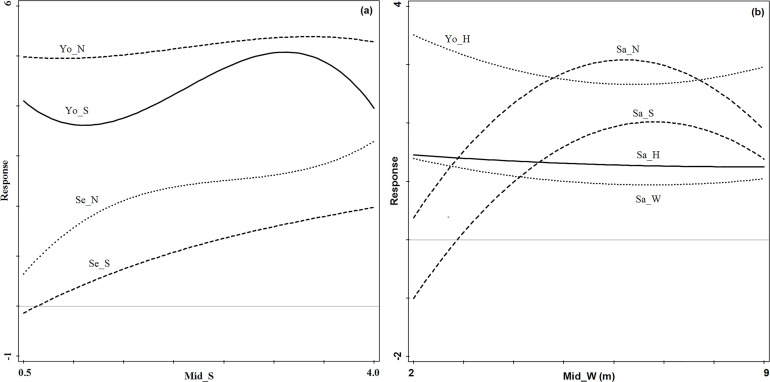
Regeneration response curves to the most important middle forest
stratum structure indices in the evergreen broad-leaved forest (Fig
8A: Mid_S; Fig 8B: Mid_W). Se_N and Se_S denote seedling density and
tree species richness index, respectively; Sa_N, Sa_H, Sa_W and Sa_S
denote sapling density, tree height, crown width and tree species
richness index, respectively; Yo_N, Yo_H and Yo_S denote young tree
density, tree height and tree species richness index,
respectively.